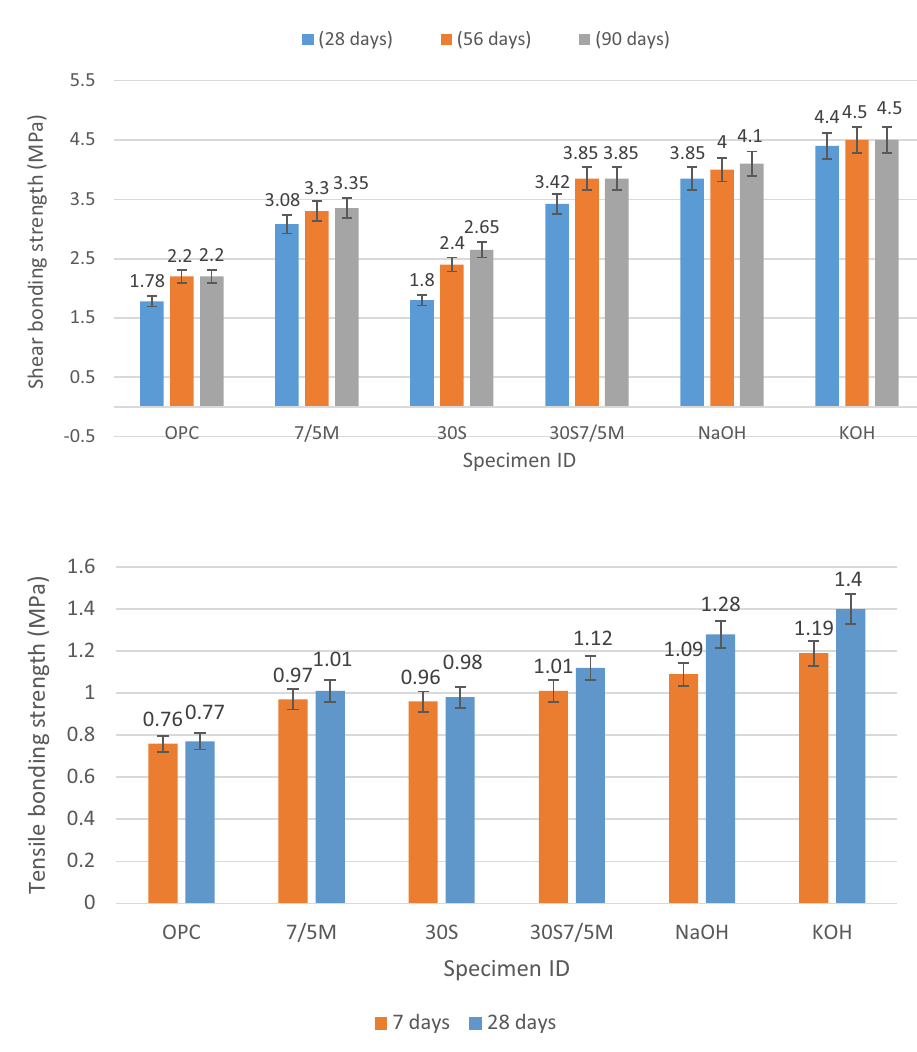
Fig. 10 The shear bonding strength for various coating